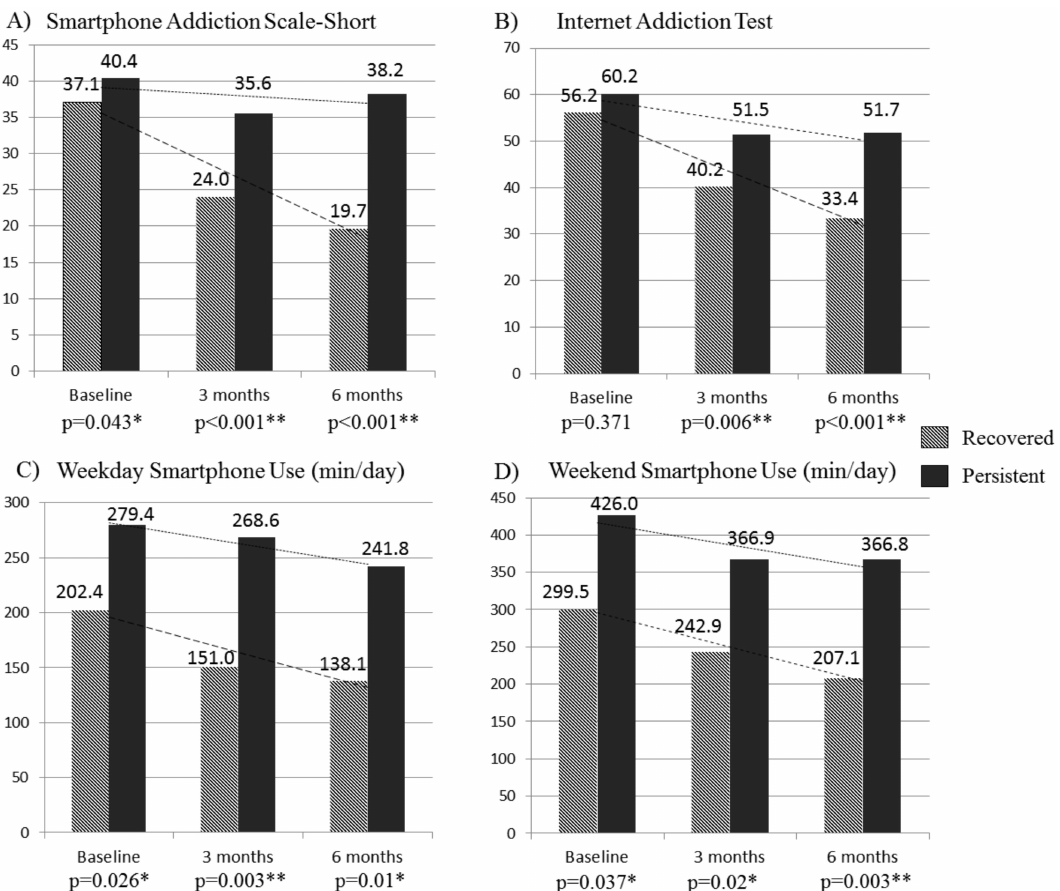
Figure 1. Longitudinal course of smartphone problems by recovery status. * p < 0.05, ** p <